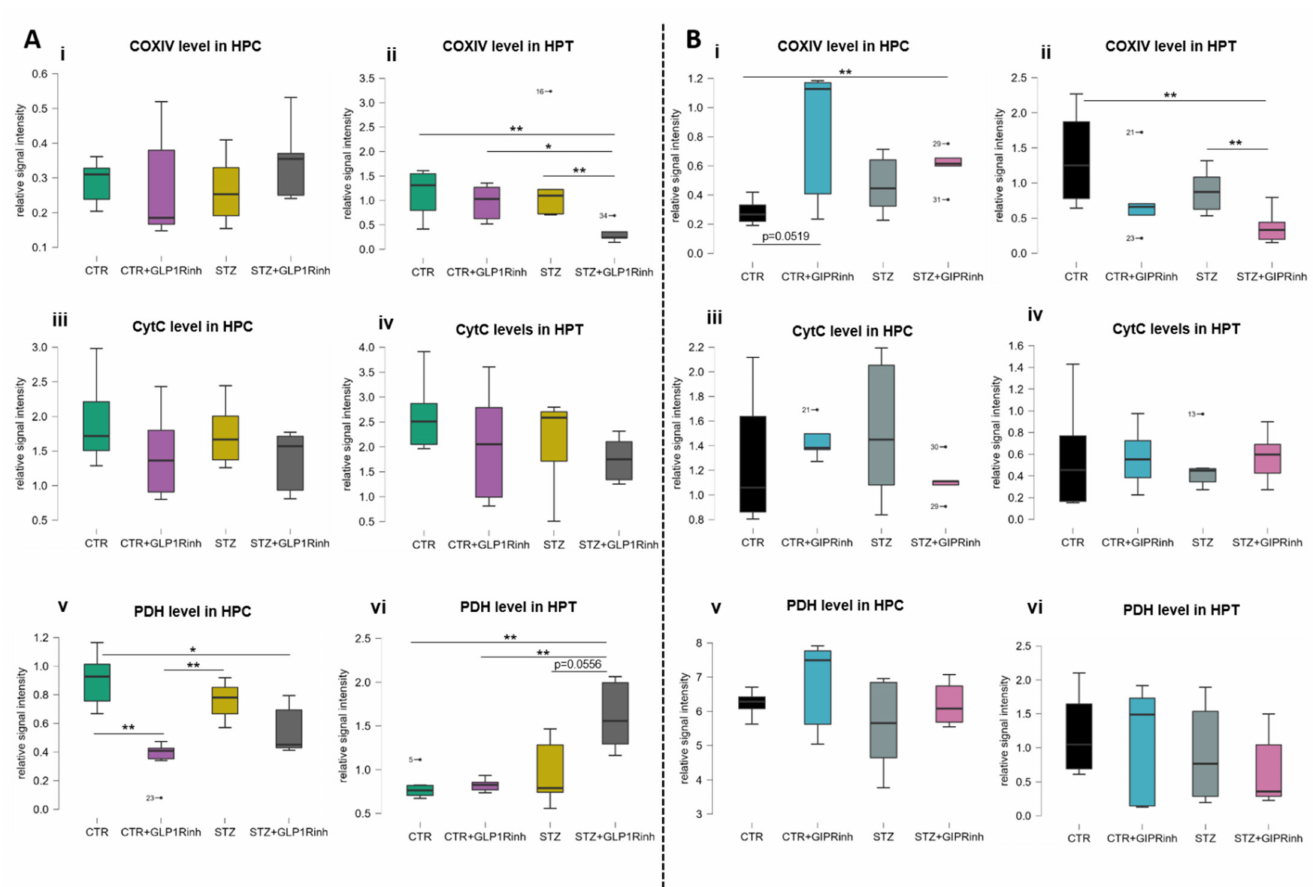
Figure 3. Impact of central glucagon-like peptide-1 and gastric inhibitory polypeptide inhibition on the levels of cytochrome C, cytochrome C oxidase IV, and pyruvate dehydrogenase in the hip- pocampus and hypothalamus. One month after intracerebroventricular (icv) streptozotocin (STZ) or vehicle (CTR) administration, rats were injected icv with 85 µ g/kg of glucagon-like peptide-1 receptor antagonist (Exendin fragment 9–39, GLP1Rinh; experiment 1) or 85 µ g/kg of gastric in- hibitory polypeptide receptor antagonist (Pro3-GIP, GIPRinh; experiment 2) dissolved in saline or with saline only (CTR and STZ). Animals were sacrificed 30 min after icv administration and the hippocampus (HPC) and hypothalamus (HPT) were dissected, homogenized/sonicated, and protein concentration was measured. Cytochrome C (CytC; iii , iv ), cytochrome C oxidase IV (COXIV; i , ii ), and pyruvate dehydrogenase (PDH; v , vi ) levels in the HPC and HPT were measured by Western blot analysis 30 min after central GLP1R ( A ) and GIPR ( B ) inhibition. Values are presented as boxplots with marked outliers and data analyzed by a non-parametric Kruskal–Wallis one-way ANOVA test followed by a Mann–Whitney U test (* p < 0.05; ** p <